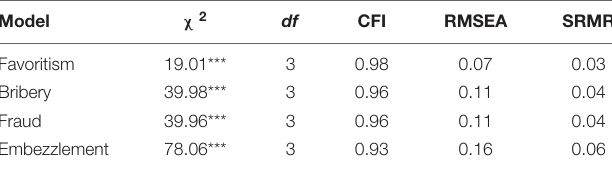
TABLE 2 | Fit statistics of corruption